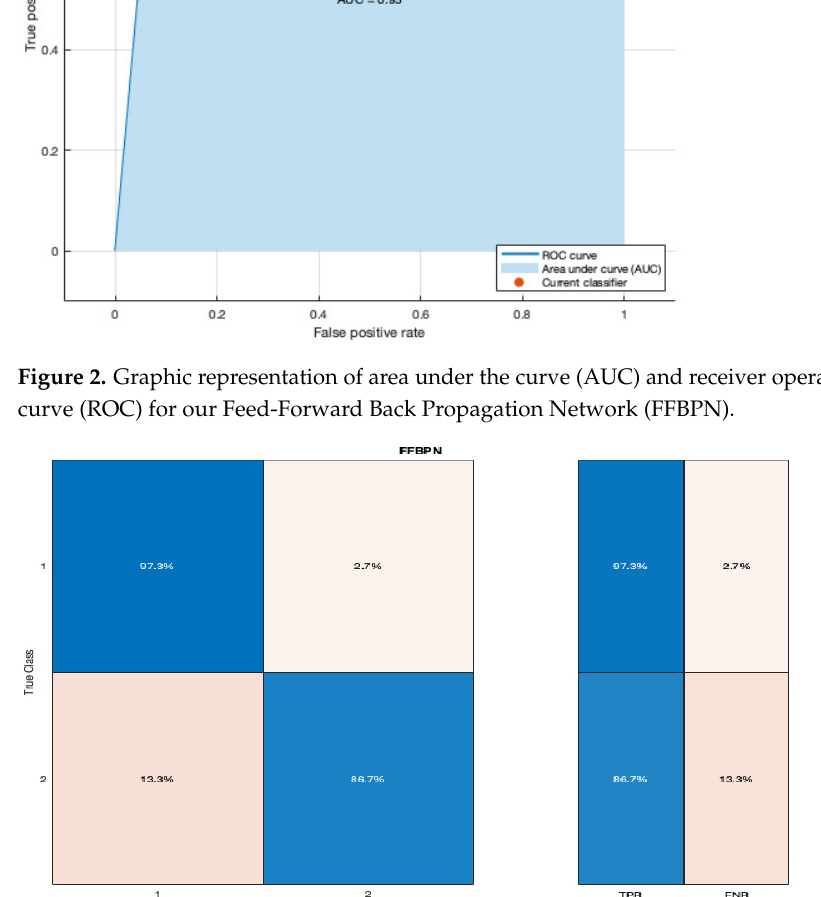
Figure 2. Graphic representation of area under the curve (AUC) and receiver operating characteris- tic curve (ROC) for our Feed-Forward Back Propagation Network (FFBPN).